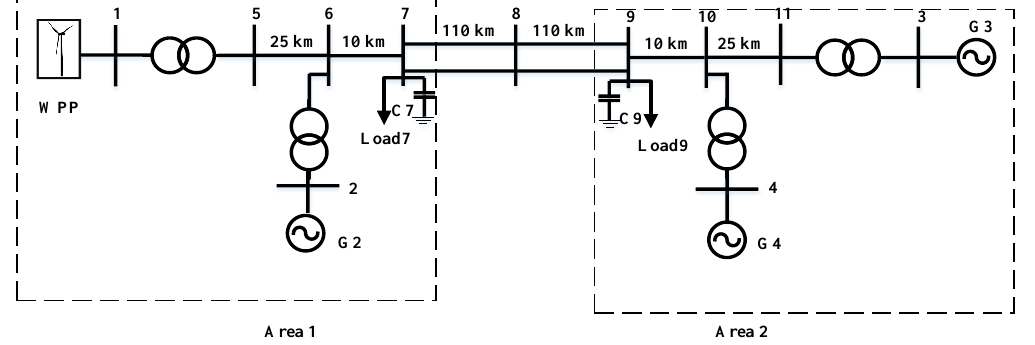
Figure 6. Two-area test system with G1 replaced by WPP.